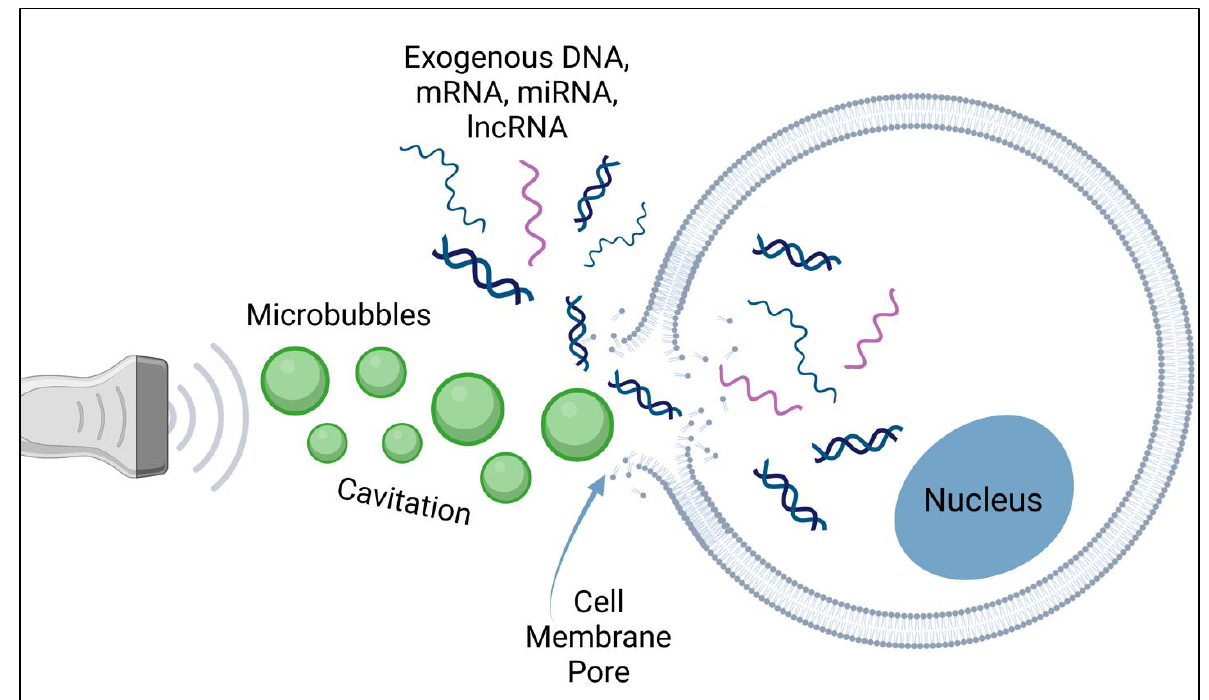
Figure 1. Image depicting the induction of a pore in the cell membrane by cavitation of microbubbles, allowing exogenous nucleic acids to passively diffuse into the cytoplasm. Created with BioRender (BioRender.com, accessed on 20 April 2022).